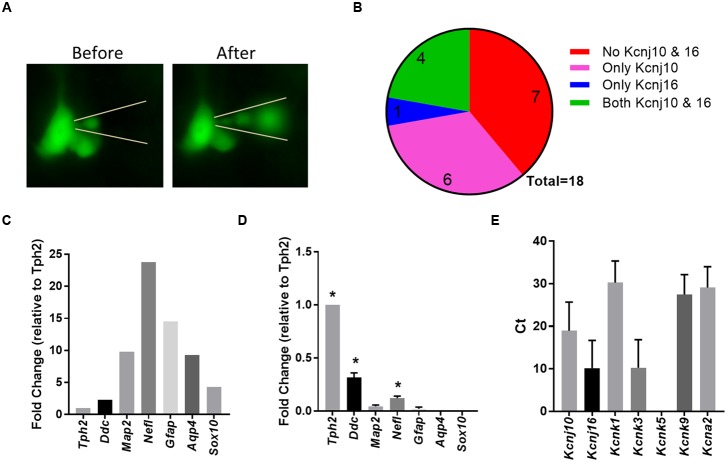
Single cell qPCR from individual 5-HT neurons confirmed Kcnj10 and Kcnj16 gene expression. (A) Representative visualization of eGFP-expressing brainstem 5-HT neuron and the isolation of the intracellular contents. (B) Number of single 5-HT neuron samples that did not express Kcnj10 & Kcnj16 (red), that only expressed Kcnj10 (pink), only Kcnj16 (blue), and both Kcnj10 and Kcnj16 (green). (C) Representative expression pattern of 5-HT specific (Tph2 and Ddc), neuronal specific (Map2 and Nefl), and glial specific (Gfap, Aqp4, and Sox10) gene markers from a bulk raphe tissue homogenate normalized to Tph2 expression. (D) Expression pattern of 5-HT specific, neuronal specific, and glial specific genes among single 5-HT neurons normalized to Tph2 demonstrating purity and specificity of single cell intracellular content isolation using single cell qRT-PCR (n = 7; ∗ vs. Gfap, Aqp4, and Sox10 by One-Way ANOVA). (E) Single cell qRT-PCR Ct-values demonstrating 5-HT specific expression of K+ channel genes, including Kcnj10 and Kcnj16 (n = 7).